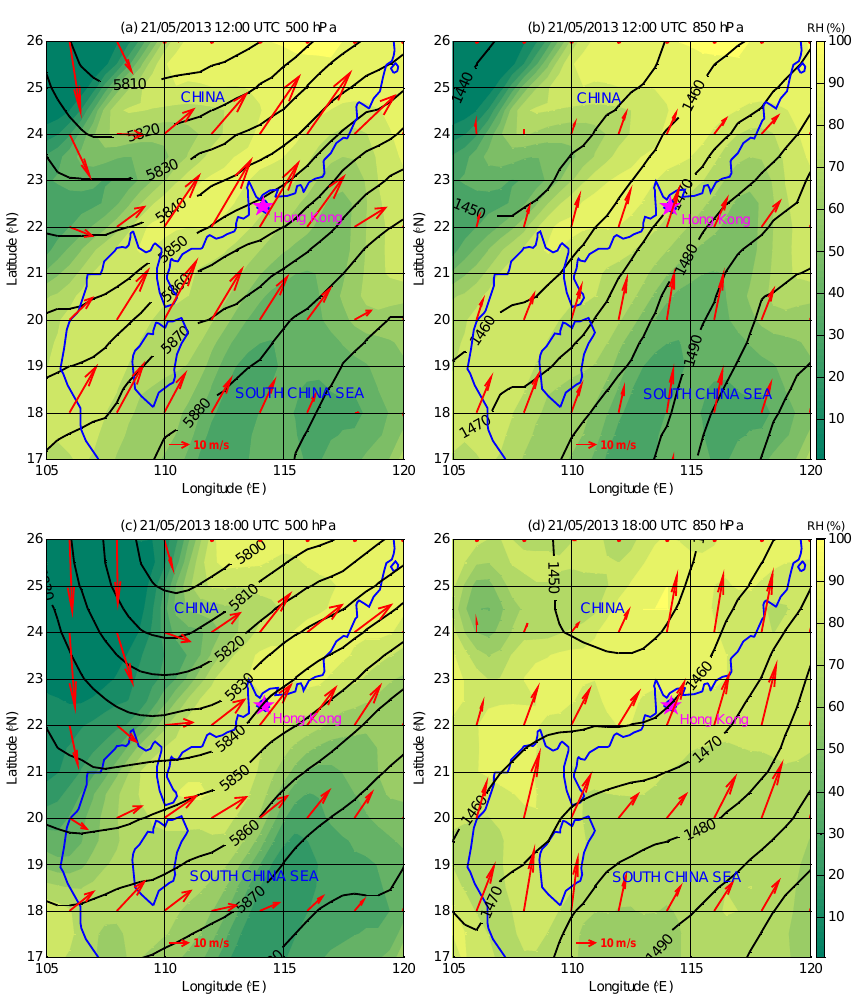
Figure 6. Isobaric analysis at (a) 500hPa and (b) 850hPa at 12:00, and (c) 500hPa and (d) 850hPa at 18:00 over southern China on 21 May 2013. The black contours represent the geopotential heights. The filled contours are relative humidities. Red arrows indicate the wind direction, and the vector scale is shown at the bottom in the middle. The meteorological data are derived from the ECMWF ERA-Interim reanalysis products.